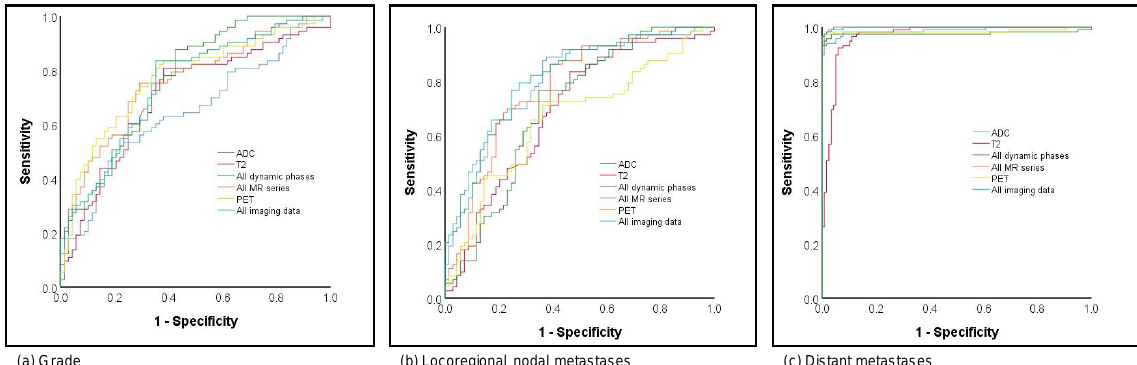
Figure 3. ROC curves for hormone ( a ) estrogene and ( b ) progesterone receptor status, ( c ) HER2 and ( d ) proliferation rate prediction.